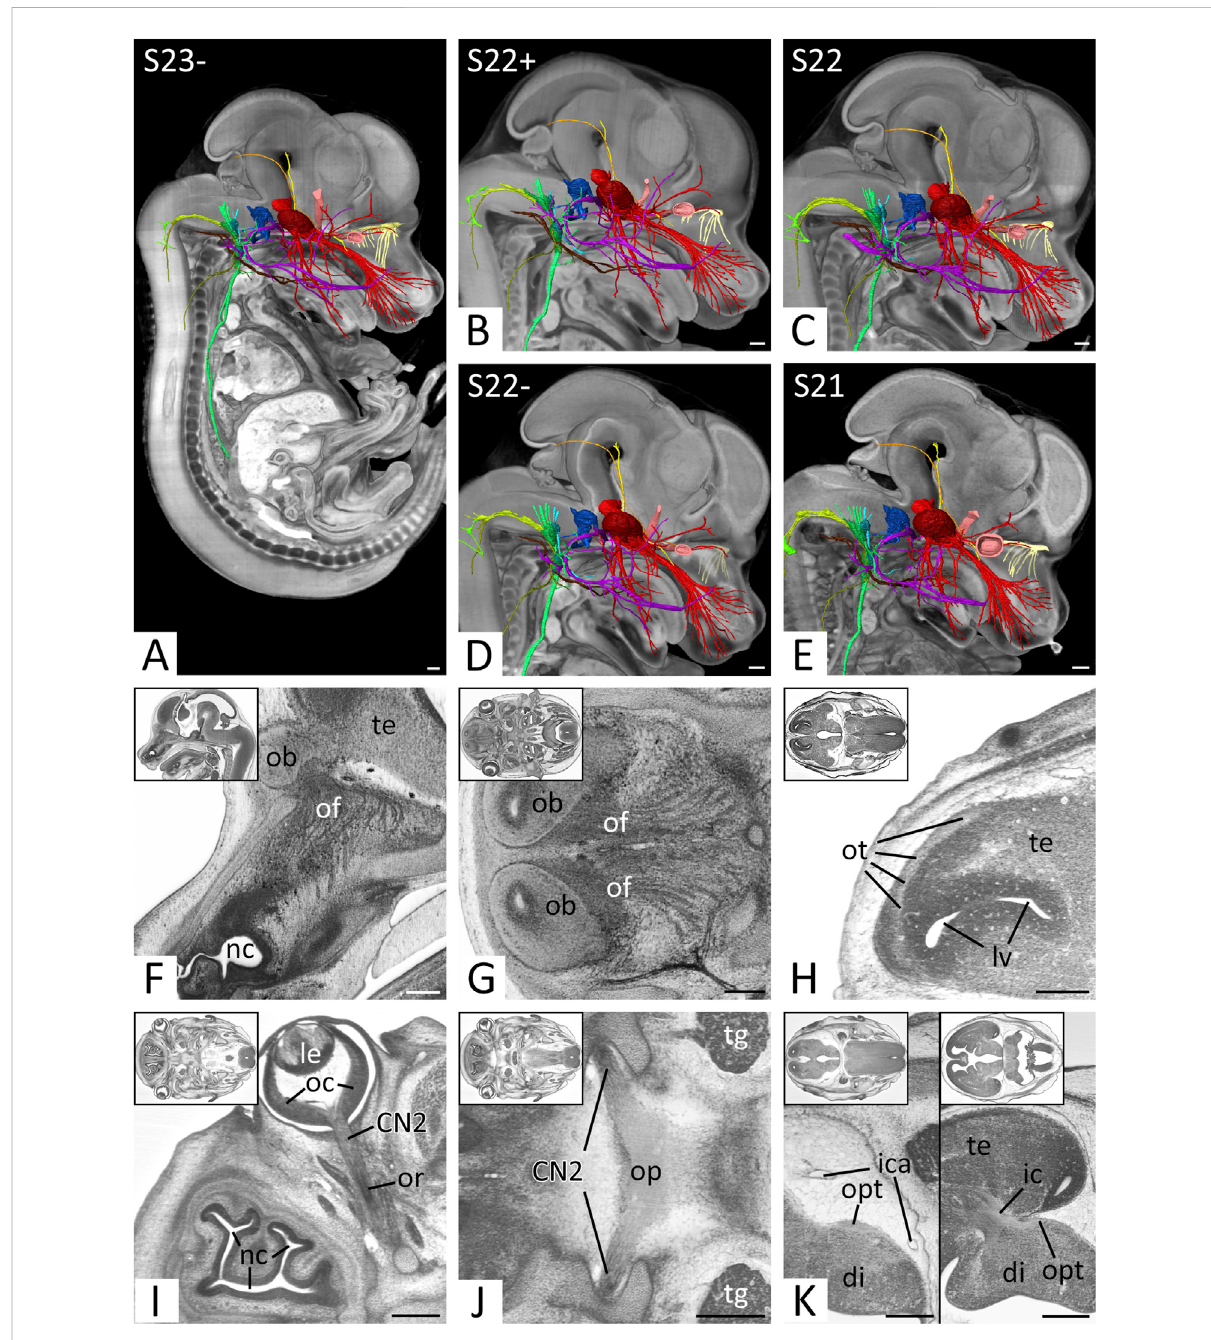
FIGURE 2 Overviewandcranialnerves(CN)1and2 (A – E) OverviewofallrightCNs.3Dsurfacerenderingsinthecontextofavolumerenderingofamouse embryoofS23- (A) ,S22+ (B) ,S22 (C) ,S22- (D) andS21 (E) .Viewfromright.TheoverviewofS23isshowninFigures4,5.CN1(lightyellow),CN2(light red), CN3 (yellow), CN4 (orange), CN5 (red), CN6 (pink), CN7 (violet), CN8 (blue), CN9 (turquoise), CN10 (green), CN11 (olive), CN12 (brown) (F – H) Olfactory nerve(CN1) insagittal (F) and axial (G,H) HREM resections. Anteriorto theleft, righton top.Inlays: Overview. (F,G) Olfactory fi bers (of) from the nasal septum (F) and superior nasal turbinate (G) reaching the olfactory bulb (ob). (H) Olfactory tract (ot) on lateral aspect of